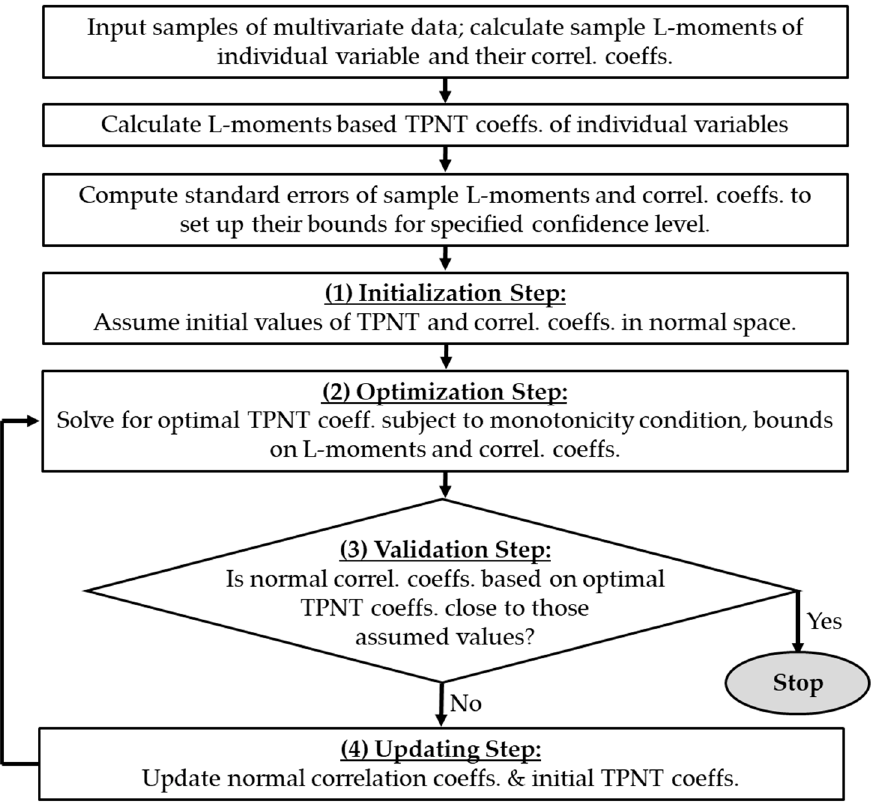
Figure 1. Flow diagram showing the procedure of multivariate TPNT modeling considering sampling errors of sample